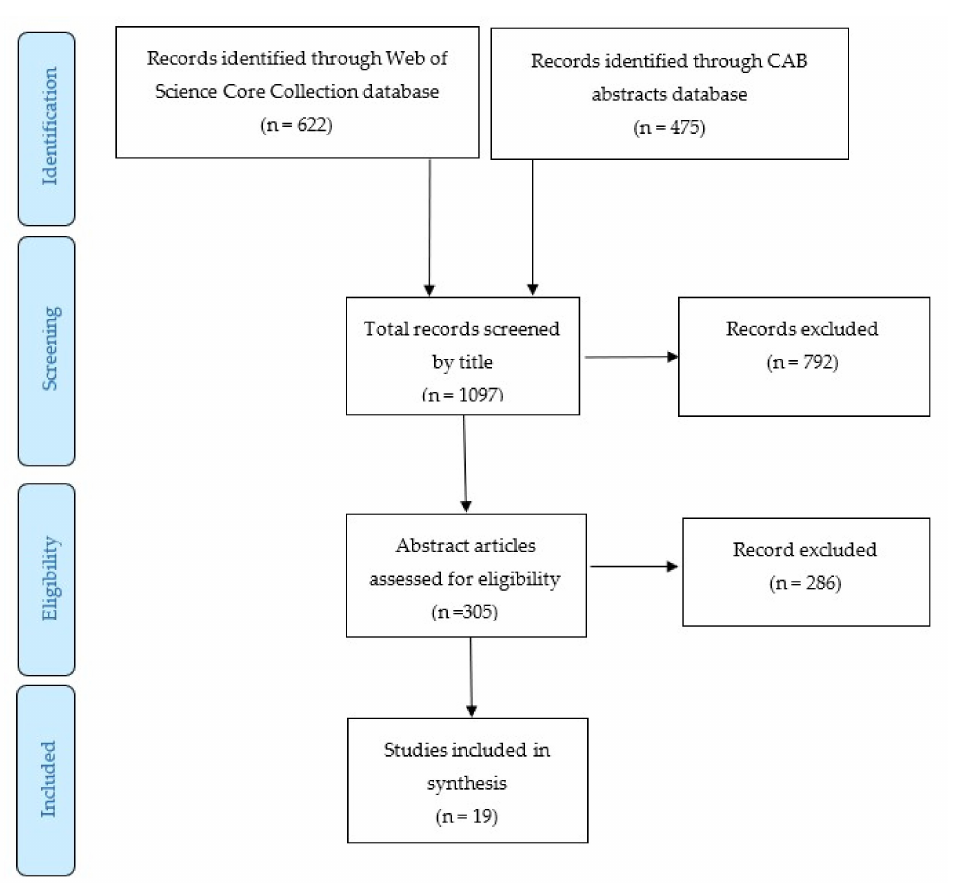
Figure 1. Preferred reporting items for systematic reviews and meta-analyses (PRISMA) diagram